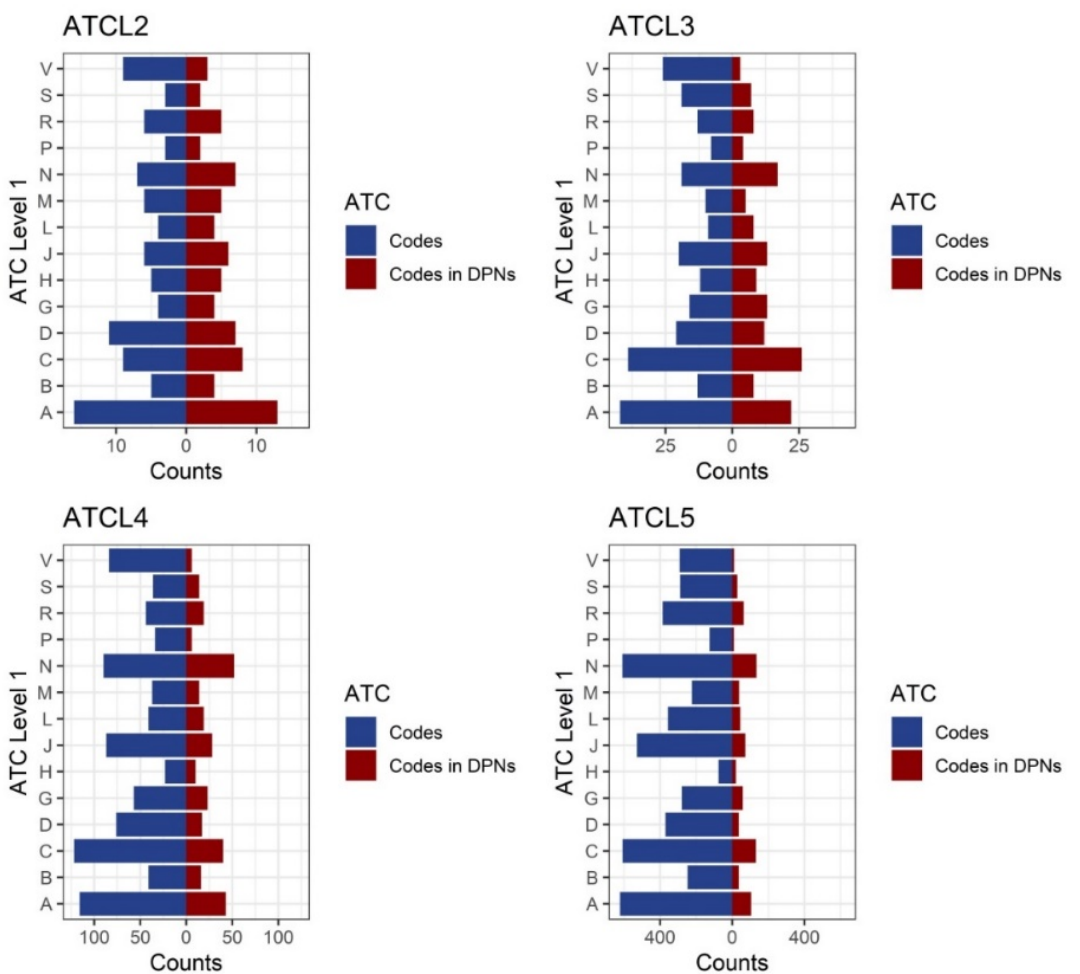
Figure A1. The ATC classification system. The ATC classification system consists of five levels and several subcategories nested within broader parent categories. The resulting structural organization of the ATC codes is shown in the figure. In particular, the ATC codes were counted both in the overall system (blue columns) and, for comparison, in the DPNs (dark red columns) examined in this study.